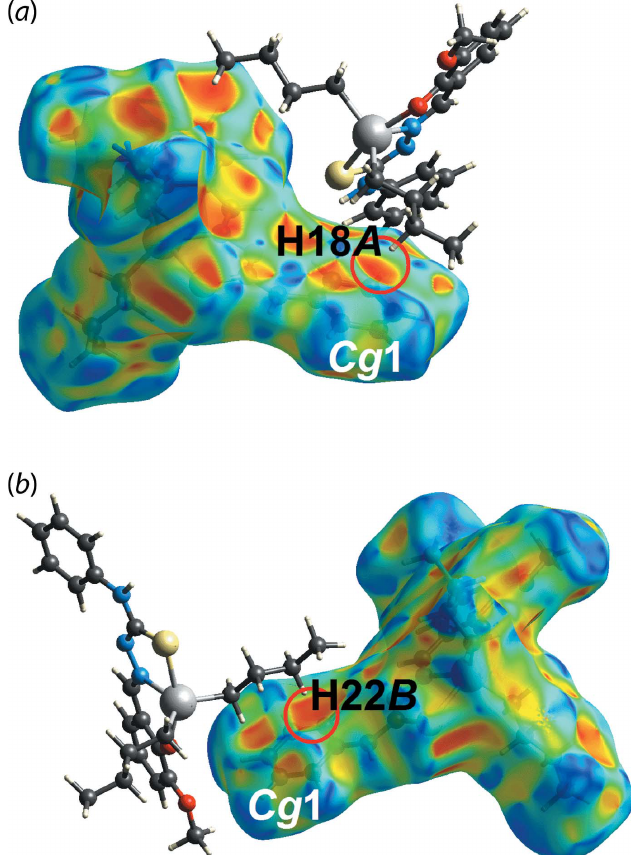
Figure 5 Views of the Hirshfeld surface for (I) mapped over the shape-index property. The influence of the ( a ) H18 A (cid:2)(cid:2)(cid:2) Cg 1 and ( b ) H22 B (cid:2)(cid:2)(cid:2) Cg 1 contacts are highlighted by the hollows emphasized by the red